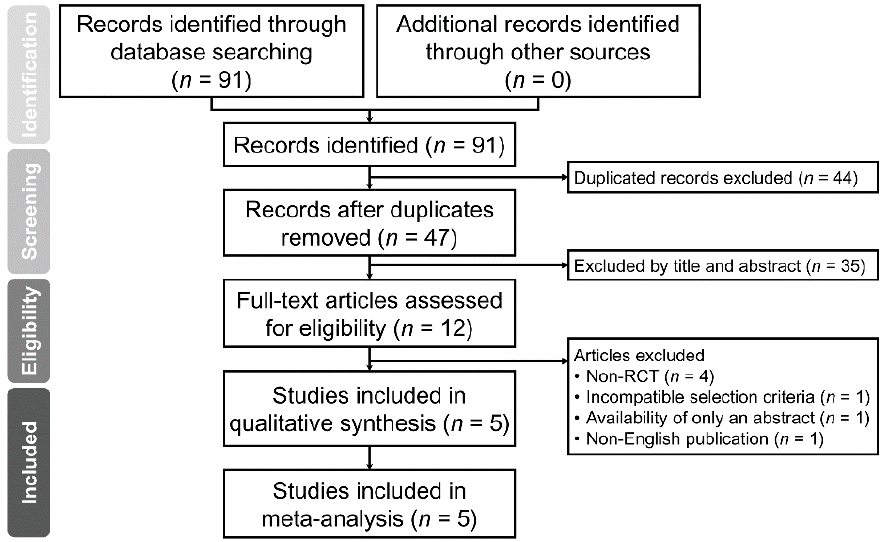
Figure 1. Meta-analysis flowchart for selecting eligible studies. RCT: randomized controlled trial.